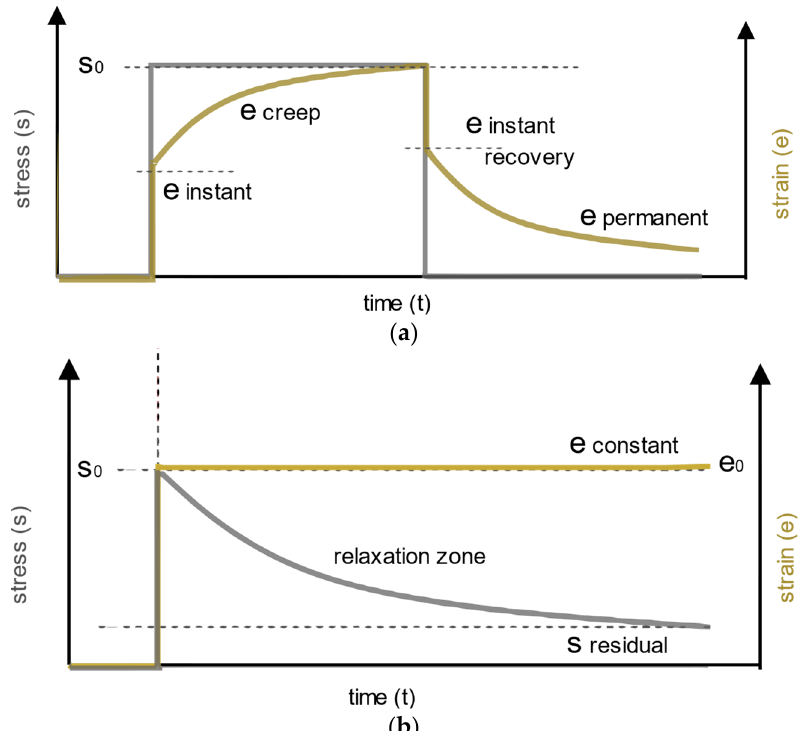
Figure 2. Stress and strain diagrams of viscoelastic material: ( a ) when constant stress is applied; ( b ) constant strain is applied. Adapted from [23], Elsevier, 2021.